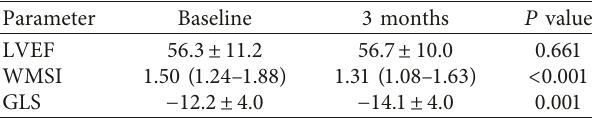
Table 1: Clinical, angiographic, and procedural characteristics. Table 2: Baseline and 3 months echocardiographic parameters.